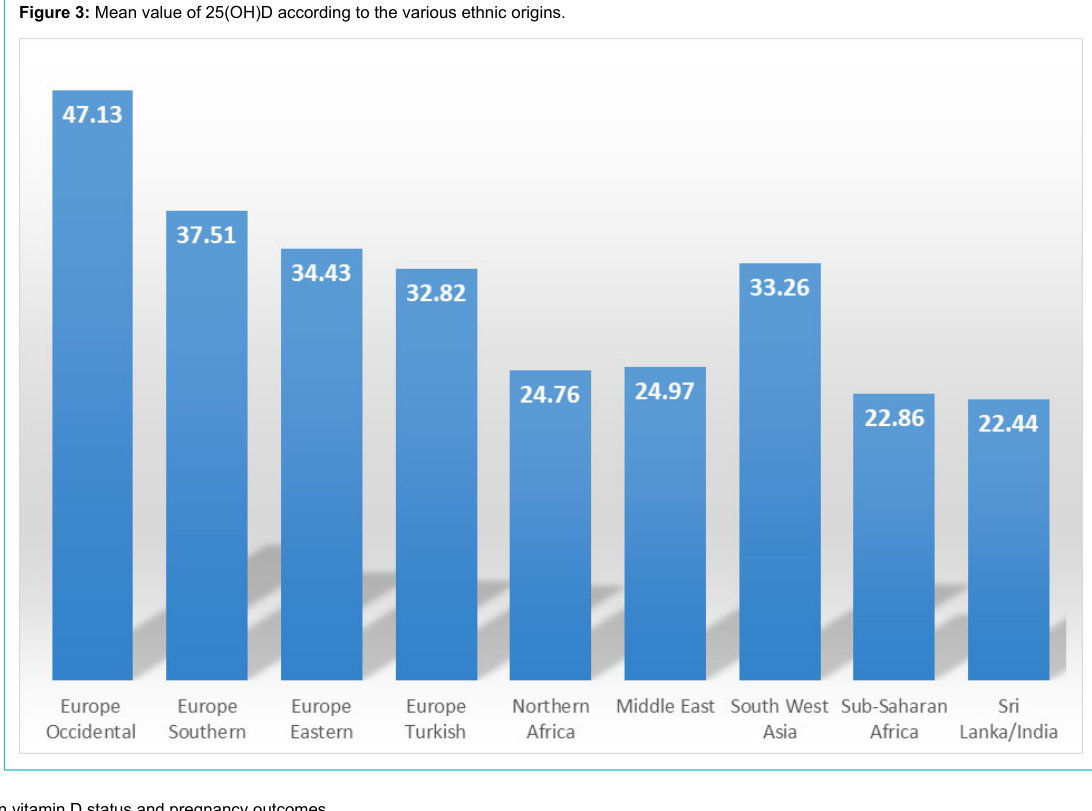
Figure 3: Mean value of 25(OH)D according to the various ethnic origins.